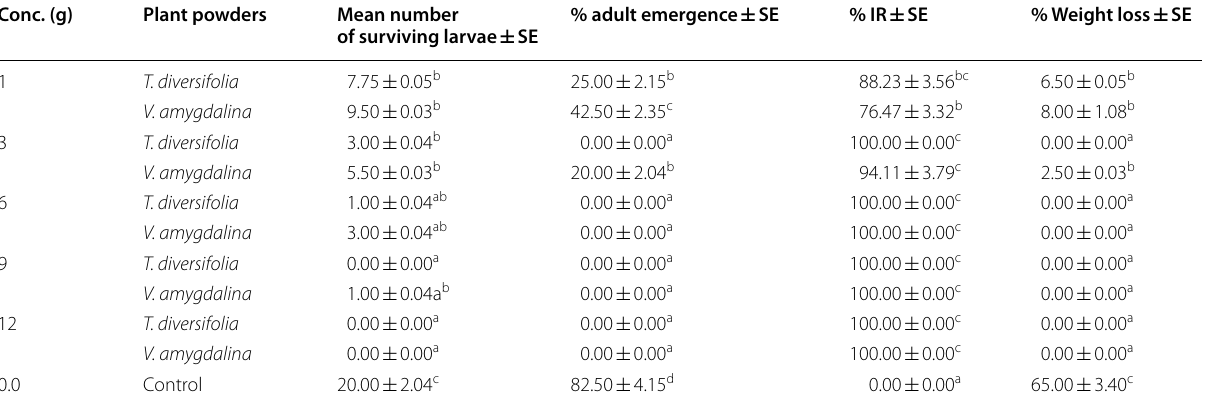
Mean followed by the same letters within the same column are not significantly different ( P >0.05)